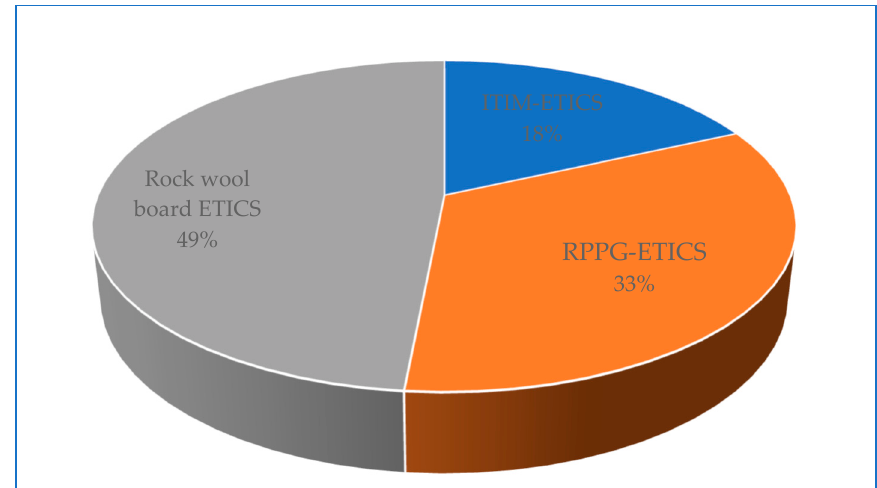
Figure 12. Proportion of types of ETICS with insufficient bonding strength.